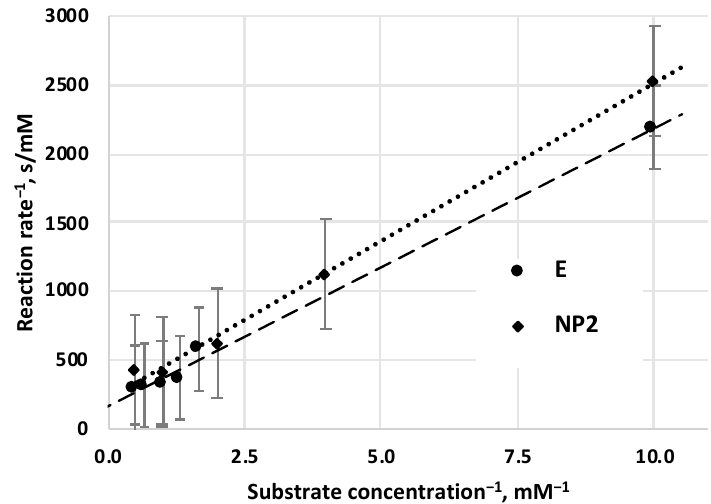
Figure 4. Reciprocal values of initial reaction rate ( v 0 ) as a function of reciprocal substrate concentration obtained by free (not immobilized) α -chymotrypsin enzymes (E) and enzyme nanoparticles (NP2, prepared by two-step synthesis method) plotted by Lineweaver–Burk method.